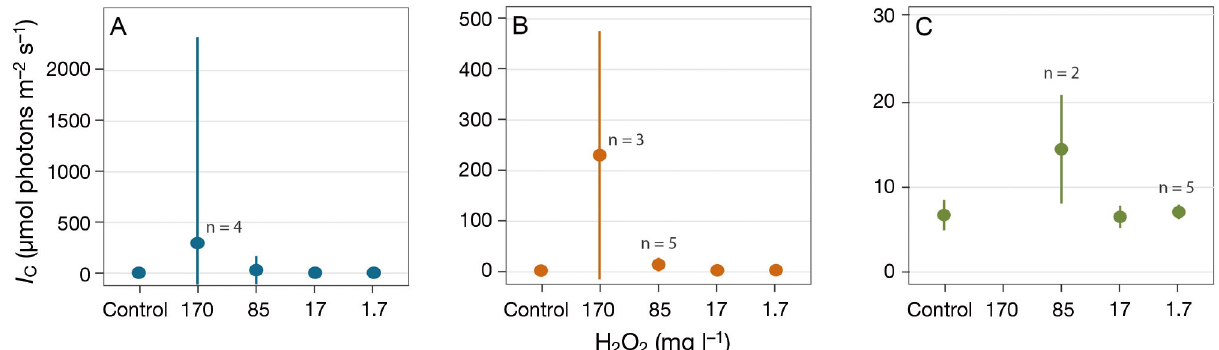
Fig. 6. Effect of 1 h exposure to 5 different concentrations of H 2 O 2 , including control, on the light compensation irradiance ( I C ) of juvenile Saccharina latissima plants. Median (±1 SD) response (A) immediately post-exposure (Day 0), (B) 24 h post- exposure (Day 1), and (C) 15 d post-exposure (n = 6 unless otherwise stated). Note different y-axis